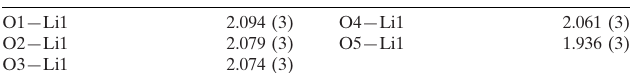
Selected bond lengths (A˚